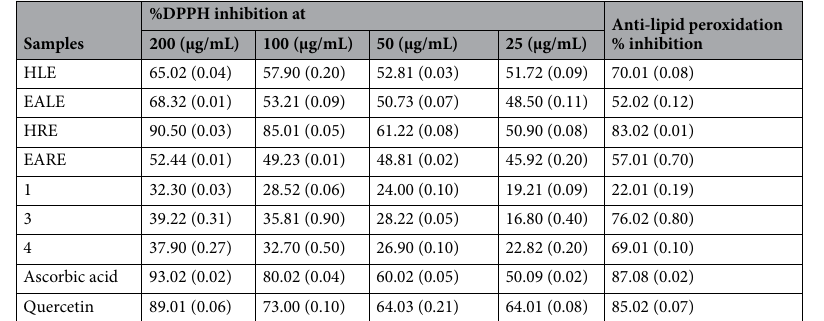
Table 4. DPPH radical scavenging and lipid peroxidation inhibitory activities of extracts and constituents of the roots and leaves of O. cufodontii . HLE hexane leaves extract, EALE EtOAc leaves extract, HRE hexane root extract, EARE EtOAc root extract; Samples were reported as mean ± SEM; Ascorbic acid and quercetin used as positive control were measured at 100, 50, 25 and 12 µg/mL.